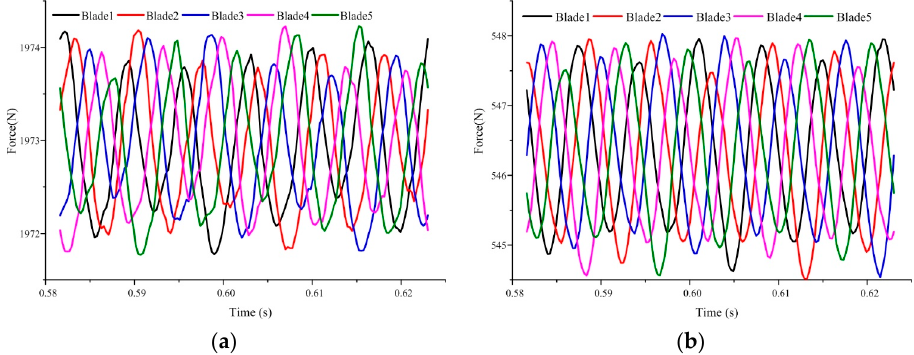
Figure 10. Time revolution of radial force on blade pressure and suction sides for 1 mm tip clearance: ( a ) Blade pressure side and ( b ) Blade suction side.